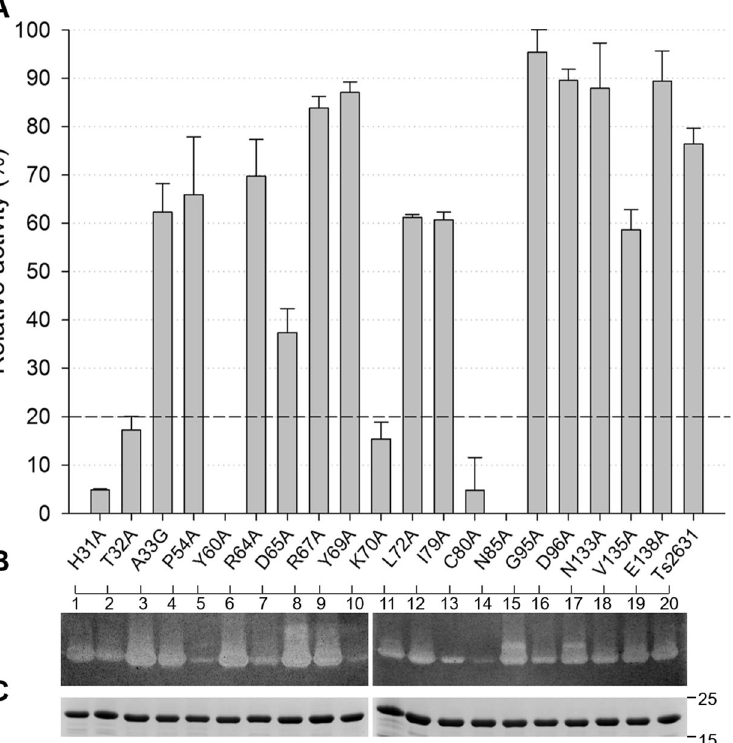
Figure 6. Lytic activity of Ts2631 endolysin variants at 37 °C. ( A ) Bacteriolytic activity was measured in a standard turbidity assay against chloroform-treated T. thermophilus HB8 substrate at 37 °C. Activities are expressed as percentages relative to the maximal lytic activity achieved among the dataset (note that the activity of native Ts2631 endolysin is not 100% under these experimental conditions). The dark gray dashed line represents 20% activity. Error bars indicate the standard deviation (n = 3). ( B ) Zymogram analysis of purified Ts2631 endolysin variants. Numbers 1–10 correspond to H31A, T32A, A33G, P54A, Y60A, R64A, D65A, R67A, Y69A, K70A (first gel), respectively, and numbers 11–20 indicate L72A, I79A, C80A, N85A, G95A, D96A, N133A, V135A, E138A and native Ts2631 endolysins (second gel). ( C ) SDS-PAGE of purified Ts2631 endolysin variants (0.5 µ g) loaded on two separate gels served as a loading control for a zymogram assay. Molecular weight markers are shown on the